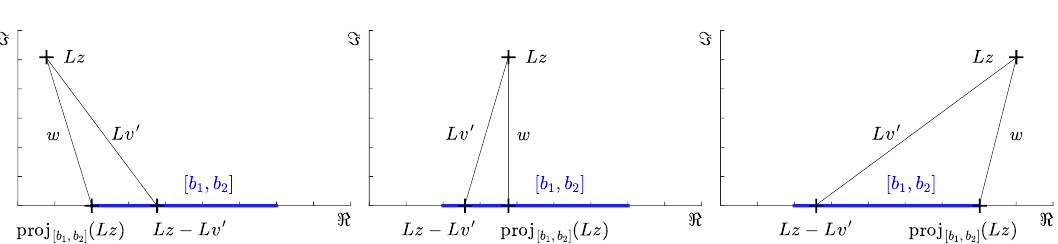
Figure 1. Illustration of the inequality in Equation (18) for different cases of the relative position of L z and the interval [ b 1 , b 2 ] . Only a single entry is depicted for each vector, i.e., the meaning of Lz in the plot is ( L z ) m and similarly for the other vectors. The point L ( z − v (cid:48) ) represents an arbitrary point in the interval [ b 1 , b 2 ] , as